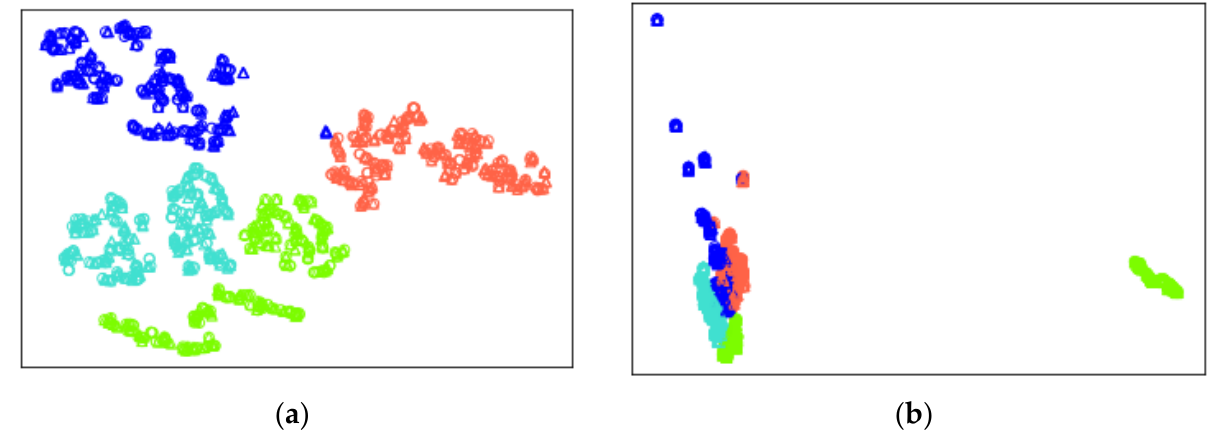
Figure 13. The visualization results of the learned features using different methods for task T3. The different colors represent different athletes’ balance control ability levels: ( a ) the result of our proposed method; ( b ) the result of the DNN method.